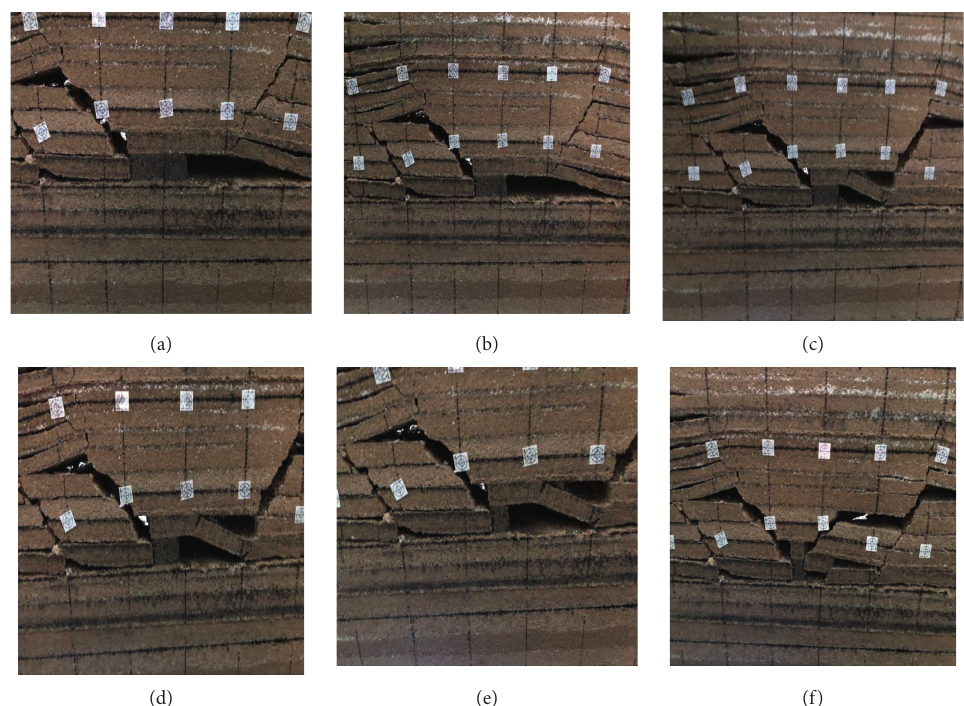
Figure 10: Movement law of overburden rock with different width coal pillars. (a) 35m coal pillar. (b) 30m coal pillar. (c) 25m coal pillar. (d) 18m coal pillar. (e) 10m coal pillar. (f) 5m coal pillar.